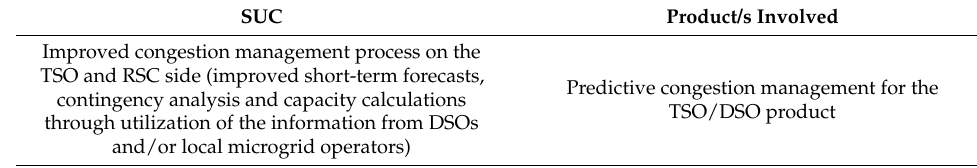
Table 1. Correlation of system use cases (SUCs) and